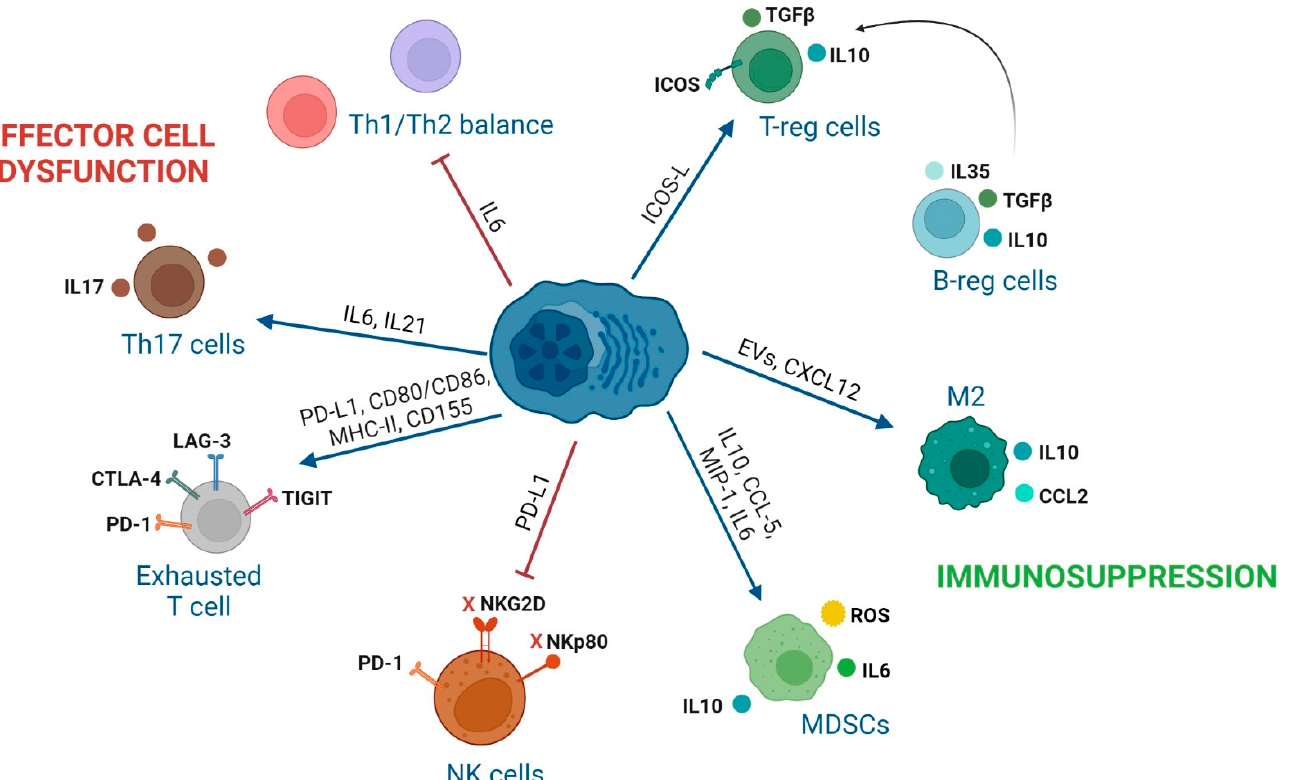
Figure 2. Summary of the impact that secreted molecules or expression of receptors by MM cells cause on the polarization and activity of immune cells. MM cells directly generate functional T regulatory (T-reg) cells contact-dependent by ICOS/ICOS-L. IL6 and IL21 secretion in the BM causes a decrease in the T helper (Th)1 cell populations leading to an imbalanced Th1/Th2 ratio. IL6 and IL21 secretion by MM cells enhance the production of Th17 cells. Over-expression of ligands of immune-checkpoint receptors in T cells causes exhaustion of T cells and natural killer (NK) cells. Secretion of IL10, CCL5, MIP-1, and IL6 from MM cells generates MDSCs with T cell suppressive ability. CXCL12 production and secretion of extracellular vesicles (EVs) by MM cells increases monocyte and induces M2 macrophage polarization.